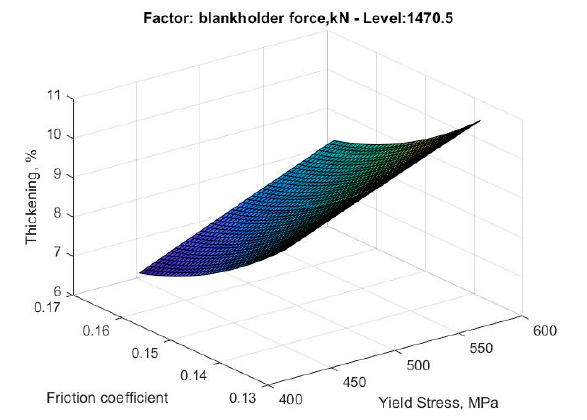
Figure 9. Metamodel of the percentage of thickened zone as friction coefficient and yield stress vary.